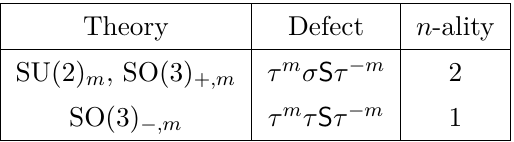
Table 1 . (Non-)invertible symmetries of su (2) at τ YM = i .